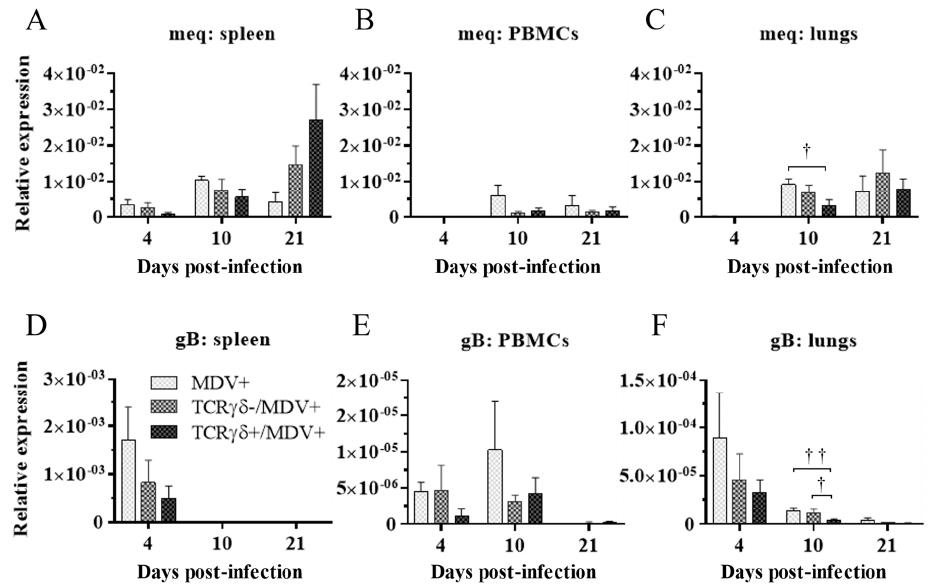
Figure 5. Transcripts of MDV genes in the spleen, PBMCs, and lungs at 4, 10, and 21 dpi. TCR γδ‐ activated or ‐ unactivated PBMCs were infused to recipient chickens at 21 ‐ days ‐ old, and the chickens were challenged with MDV. Spleen, PBMCs, and lungs samples were collected from the MDV+, the TCR γδ‐ /MDV+, and the TCR γδ +/MDV+ groups at 4, 10, and 21 dpi. Transcripts of MDV genes, meq ( A – C ), and gB ( D – F ), in the spleen, PBMCs, and lungs collected from each group at 4, 10, and 21 dpi were determined by real ‐ time PCR. Target genes were normalized by β‐ actin. Data represent the mean of 5 biological replicates ± SE in each group at each time point. Significant differences are indicated by †: p < 0.05 and ††: p < 0.01. 3.4. Lower Frequency of γδ T Cells in the Spleen of the TCR γδ‐ /MDV+ Group at 10 dpi and Higher Frequency of αβ T Cells in the Spleen and PBMCs of the TCR γδ +/MDV+ Group at 21 dpi To examine how the infusion of TCR γδ‐ activated PBMCs affects T cell frequencies in MDV ‐ challenged chickens, the frequency of γδ T cells and CD4 + αβ T cells in the spleen, PBMCs, and lungs at 4, 10, and 21 dpi was analyzed using flow cytometry. Data are pre ‐ sented as the percentage of γδ T cells or CD4 + αβ T cells within live lymphocyte popula ‐ tions. A significant decrease in γδ T cell frequency in the spleen and PBMCs was observed in the TCR γδ‐ /MDV+ group compared to the TCR γδ‐ /MDV ‐ group at 10 dpi ( p < 0.05), but not in the TCR γδ +/MDV+ group compared to the TCR γδ +/MDV ‐ group ( p ≥ 0.05) (Figure 6A,B). There were no significant differences in the frequency of γδ T cells in the lungs ( p ≥ 0.05) (Figure 6C). The frequency of CD4 + αβ T cells in the spleen, PBMCs, and lungs was significantly higher in the TCR γδ +/MDV+ group than that in the TCR γδ +/MDV ‐ group at 21 dpi ( p < 0.05) (Figure 6D–F).